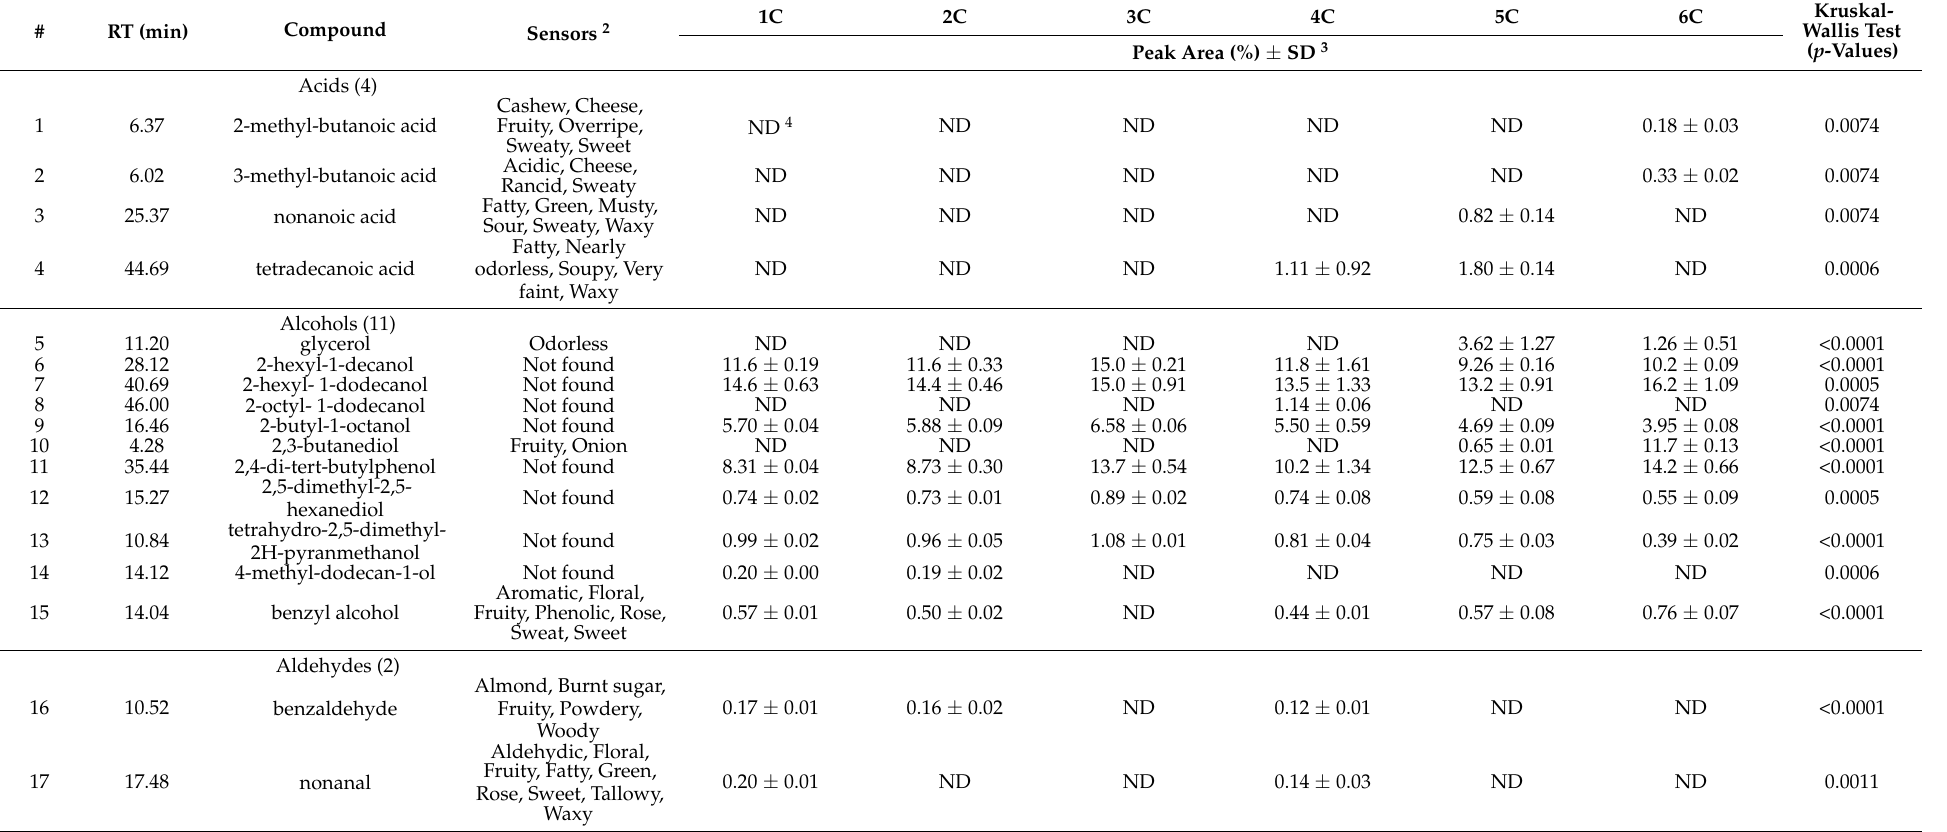
Table 1. Relative percentage (%) of volatile compounds identified in the dichloromethane extract of the Amanita rubescens caps (1–6C) 1 in various developmental stages by the gas chromatography-mass